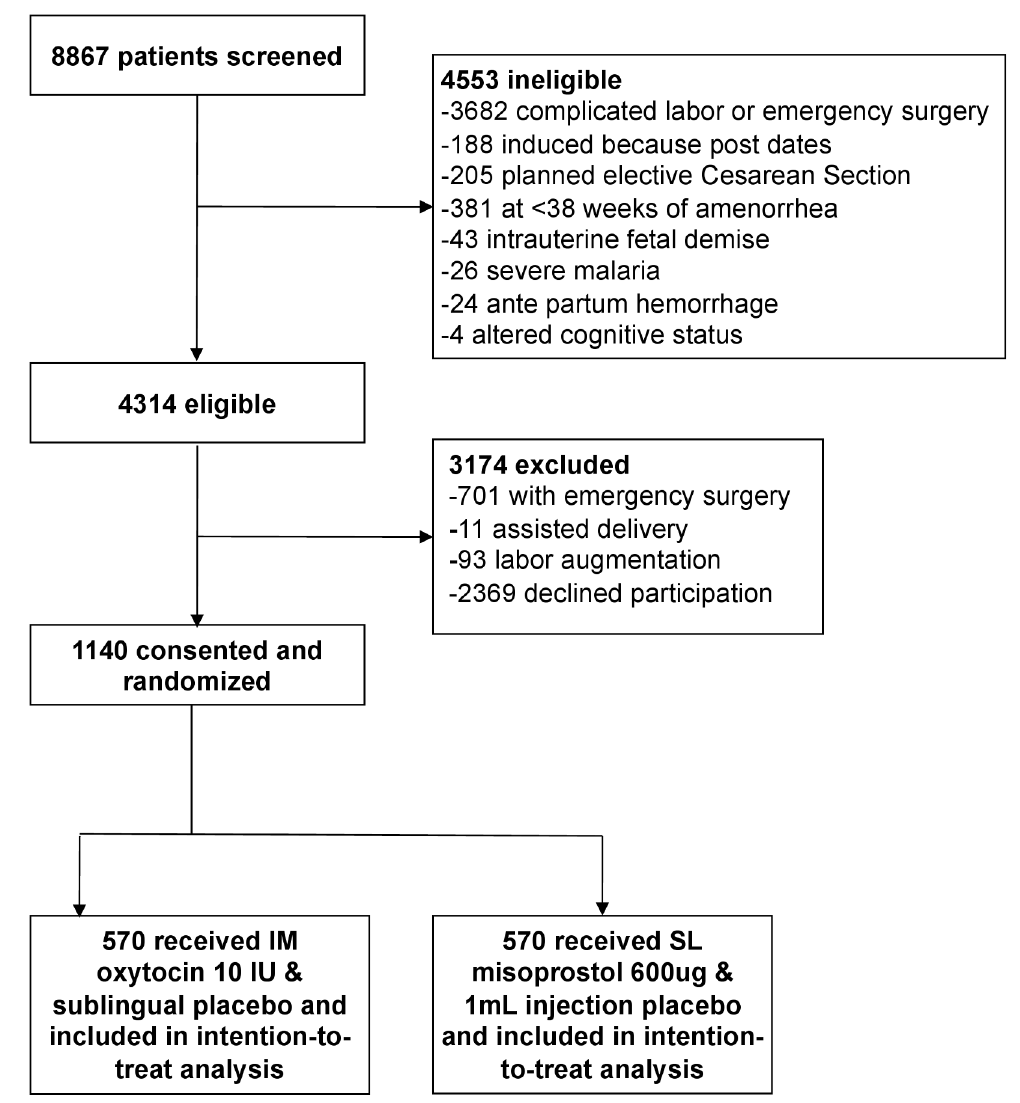
Figure 1. Trial profile. IM, intramuscular; SL, sublingual.